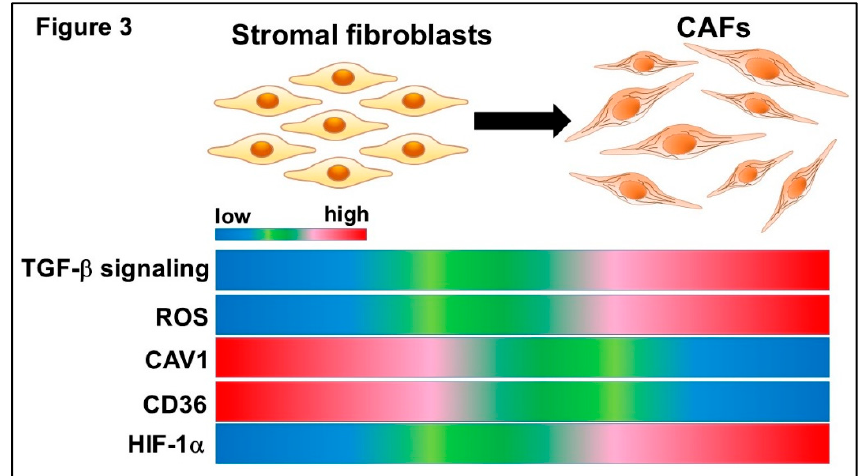
Figure 3. Metabolic reprogramming in CAFs. CD36 and caveolin 1 (CAV1) are components of caveolae, a subset of lipid rafts found in the cell membrane microdomain enriched for cholesterol and signaling proteins. These CD36 and CAV1 expressions are downregulated in CAFs. The attenuated CAV1 expression concomitantly decreases CD36 expression, stabilizes hypoxia-induced factor-1 α (HIF-1 α ), activates TGF- β signal transduction and induces myofibroblast differentiation in fibroblasts. This attenuated CD36 expression also shows a metabolic shift from mitochondrial oxidative phosphorylation to aerobic glycolysis, promoting metabolic plasticity in these fibroblasts. Tumor-derived reactive oxygen species (ROS) are responsible for down-regulation of CAV1 in CAFs. Loss of CAV1 in CAFs also results in ROS elevations, which in turn stabilize HIF-1 α .